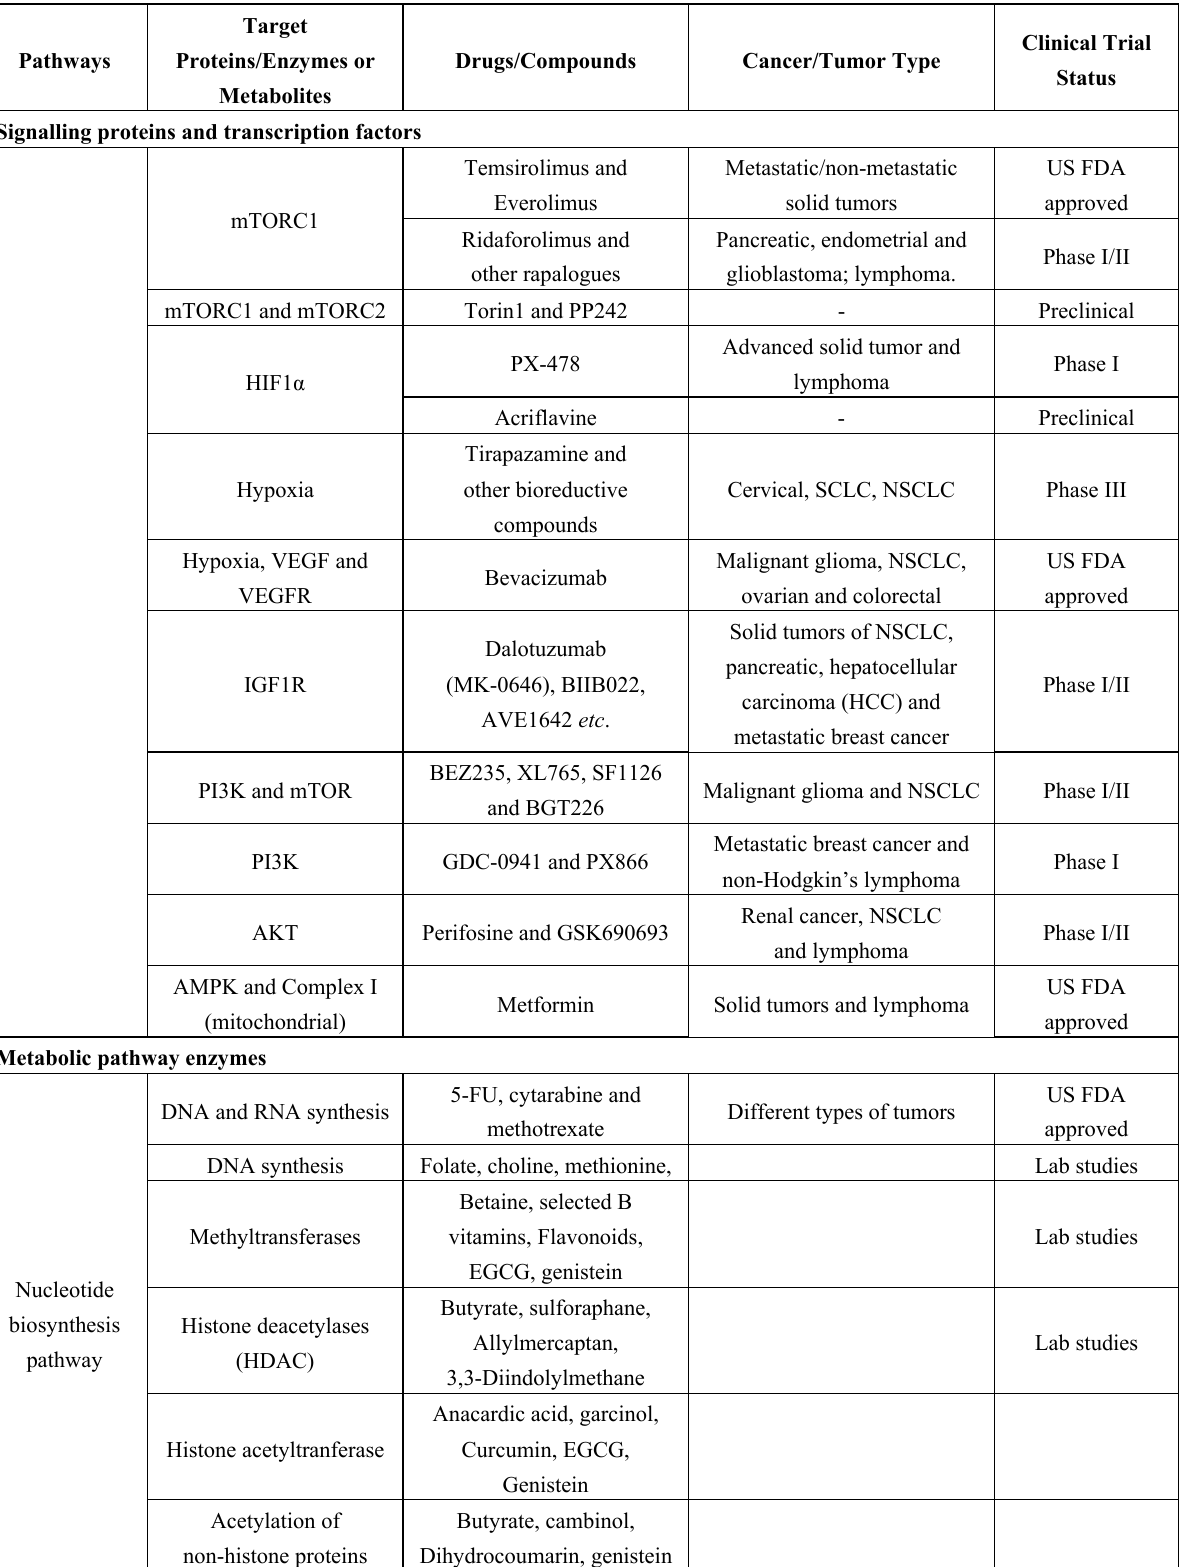
Table 1. Drugs/compounds targeting different proteins/enzymes of the metabolic pathways